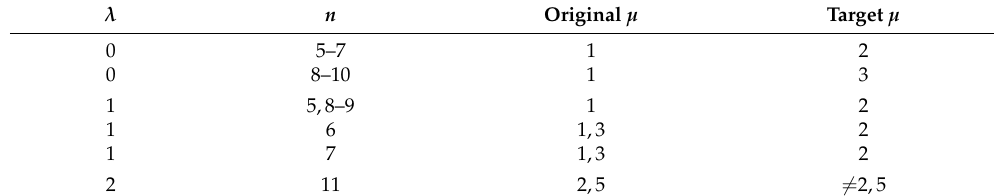
Table 22. Modifications of µ (number of spatial steps between stator phases affected by OCs in VSC legs/lines) proposed in [23] by means of electric schemes inserted between VSC and machine.